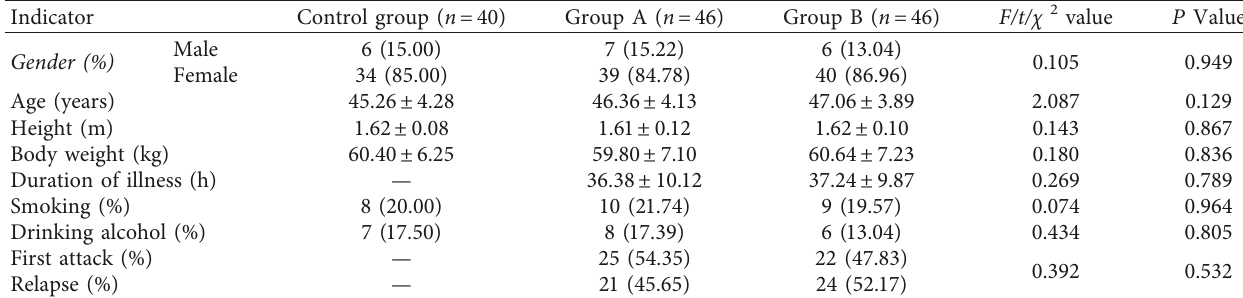
Table 1: Comparison of clinical data of the three groups ( n , Mean ±